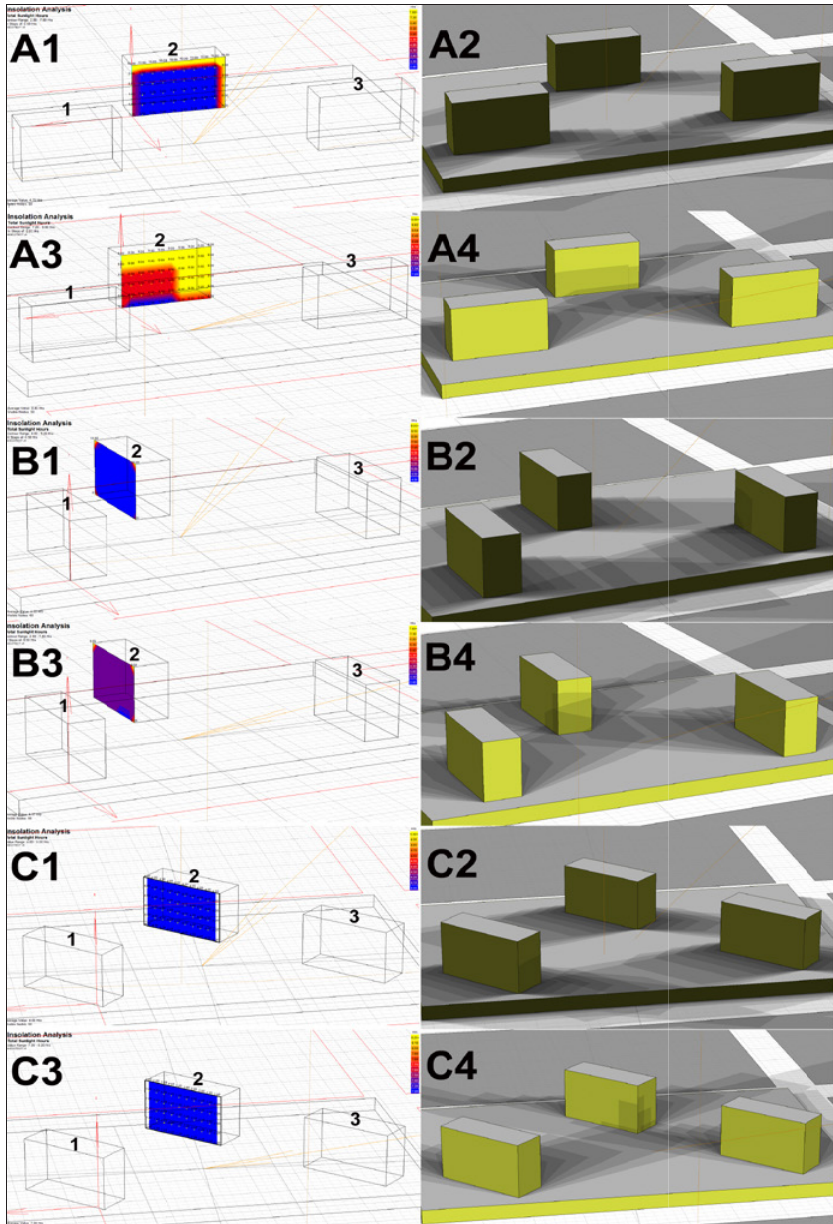
Figure 12: Solar insolation and overshadowing simulations for three different building orientations, A, B and C. A1, A2, B1, B2, C1 and C2 are calculated for summer solstice (21 December) and A3, A4, B3, B4, C3 and C4 for winter solstice (20 June). Solar insolation and shading characteristics for building configuration A using a FBC approach